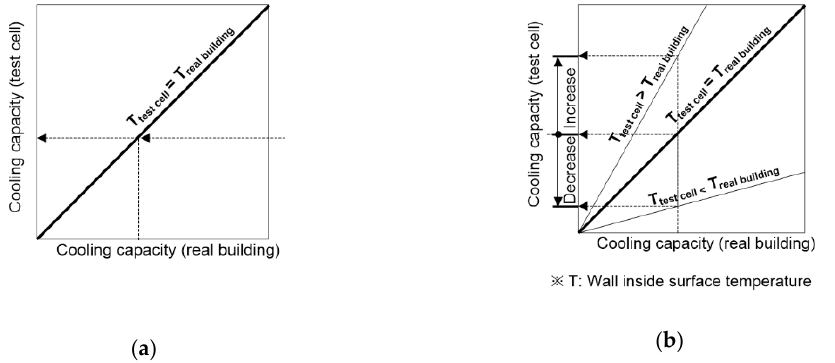
Figure 1. Evaluation of the cooling capacity of the Cooling Radiant Ceiling Panel (CRCP): ( a ) cooling capacity of the CRCP; ( b ) over or underestimated cooling capacity.